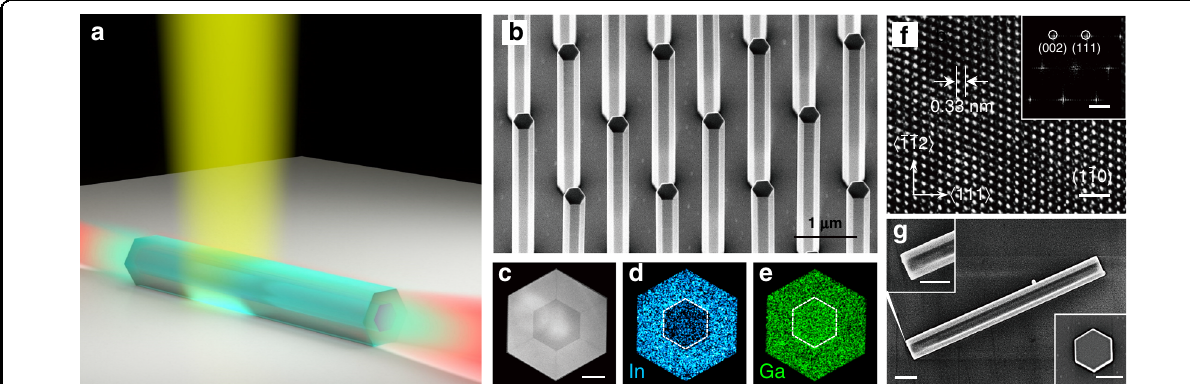
Fig. 1 Schematic illustration of the self-frequency conversion NW laser and its structural properties. a The schematic of NW laser with fundamental lasing (red light) and self-frequency-conversion lasing (cyan light) signals pumped by an 800 nm femto-second pulsed laser (yellow light). b Tilted 30° SEM image of the as-grown NW array. c – e HAADF-STEM ( c ), In ( d ) and Ga ( e ) mapping images of the NW cross-section. Scale bar is 100 nm. f HRTEM and FFT (inset) images taken along h 110 i zone axis of the NW showing a zincblende crystal structure. Scale bar is 1 nm. Scale bar of inset is 2 nm − 1 . g SEM image of a NW transferred onto a SiO 2 /Si substrate. Upper-left inset and bottom-right inset show the zoomed images of the end facet of the transferred NW and end facet of a standing NW, respectively, indicating the high facet quality of the NW as an optical cavity. All scale bars are 500